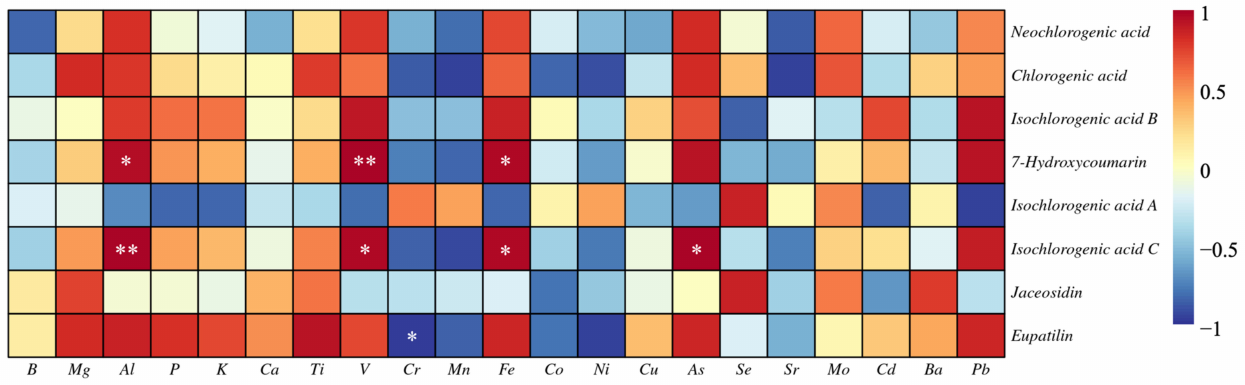
Figure 5. Correlation heat map between elements and bioactive compounds of A. argyi . * indicates a significant correlation ( p < 0.05). ** indicates a significant correlation ( p <